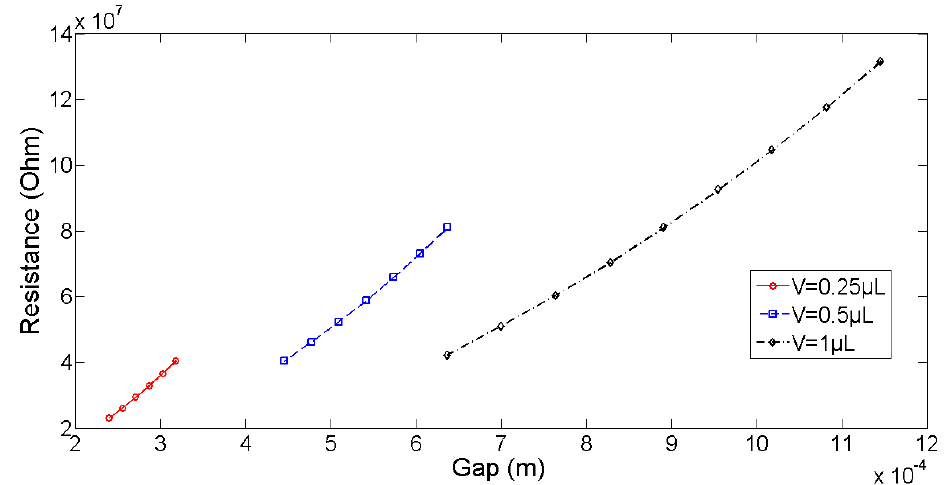
Figure 6. Electrical resistance of a meniscus anchored between two circular pads as a function of the meniscus height for different volumes of liquids. Simulation parameters: pad radius = 0.5 mm, surface tension = 72 mN/m and liquid conductivity = 1e − 5 S/m.